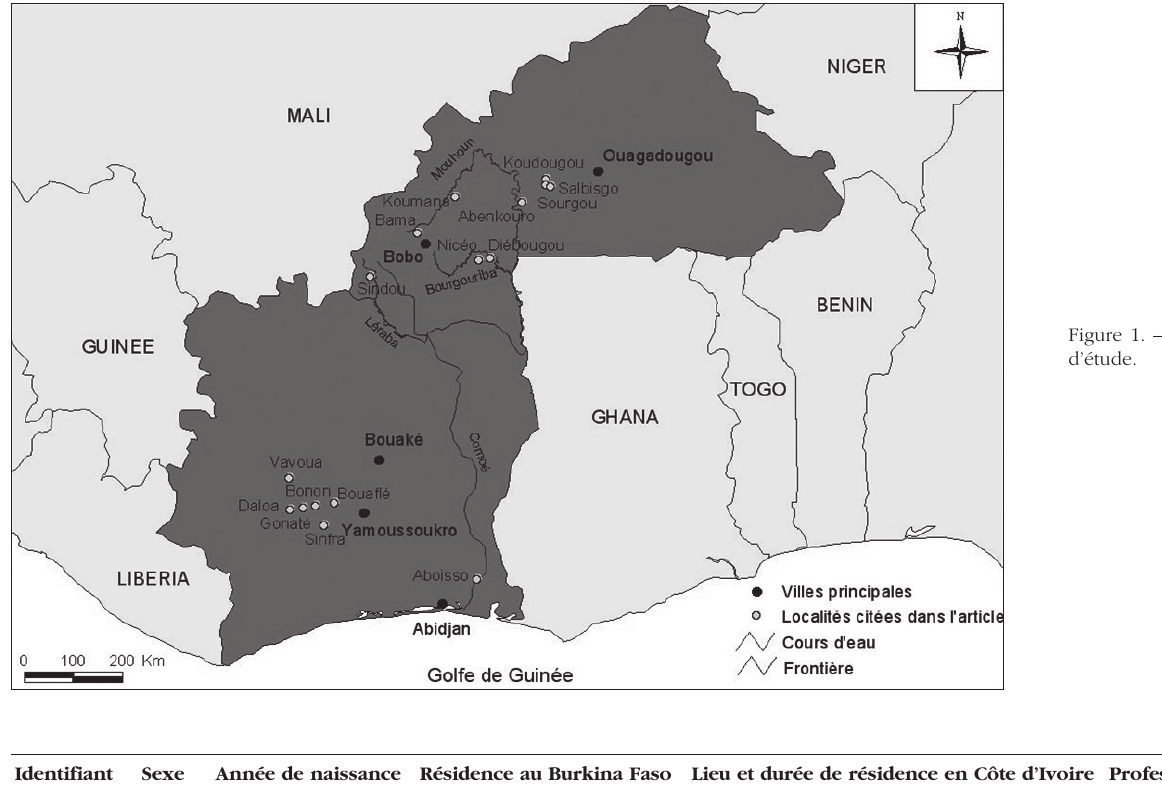
Figure 1. – Zone d’étude.